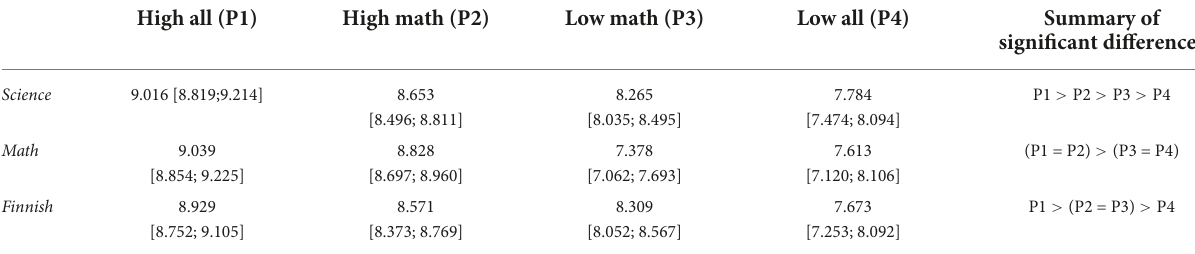
TABLE 2 Achievement difference in each profile.